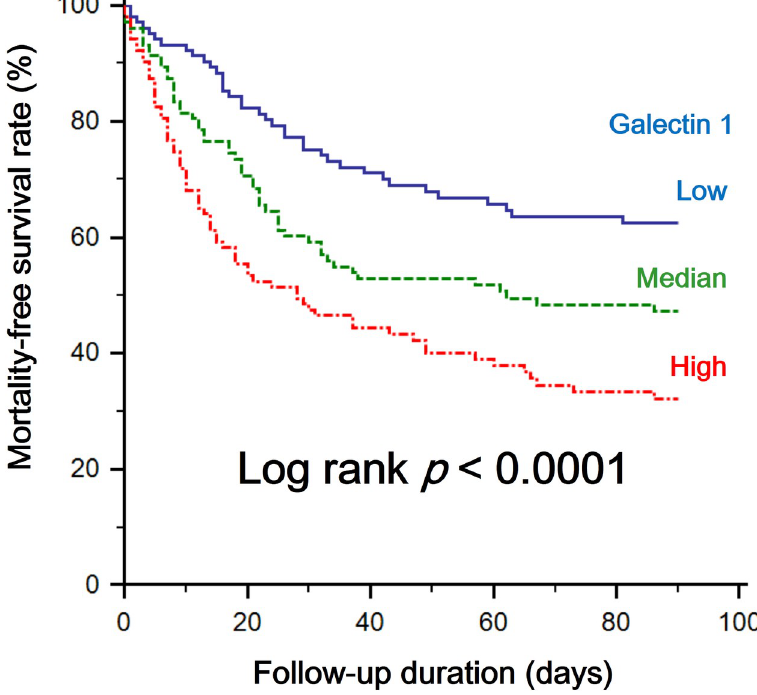
Fig 2. Kaplan–Meier curves of freedom from 90-day mortality in patients grouped by serum galectin-1 concentrations.